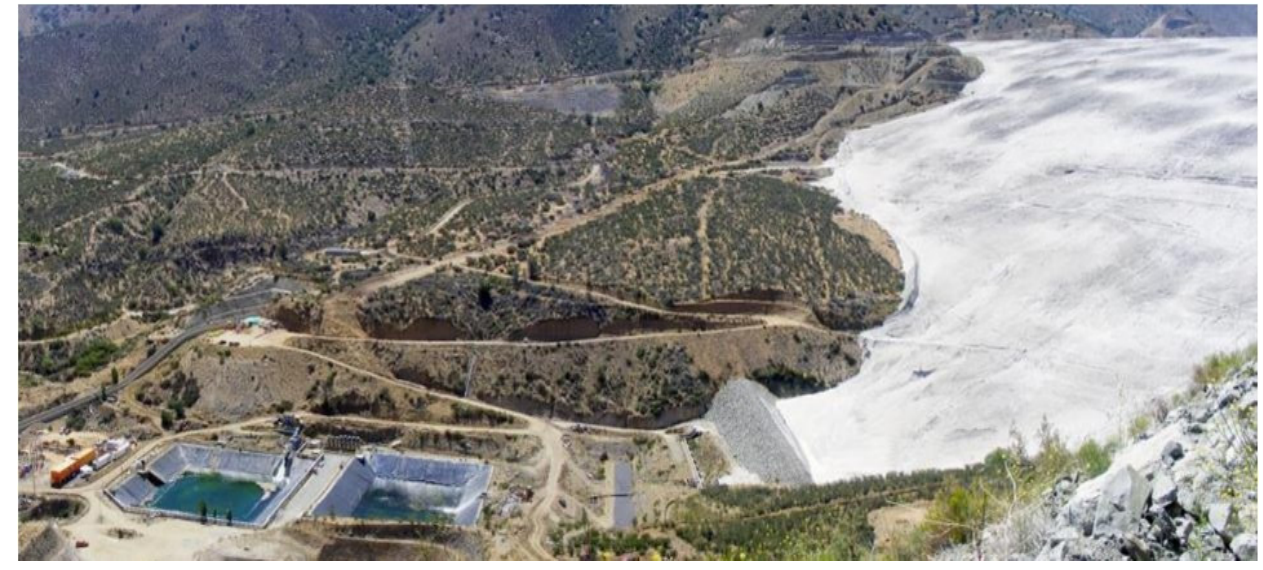
Figure 12. Seepage collection sumps in a